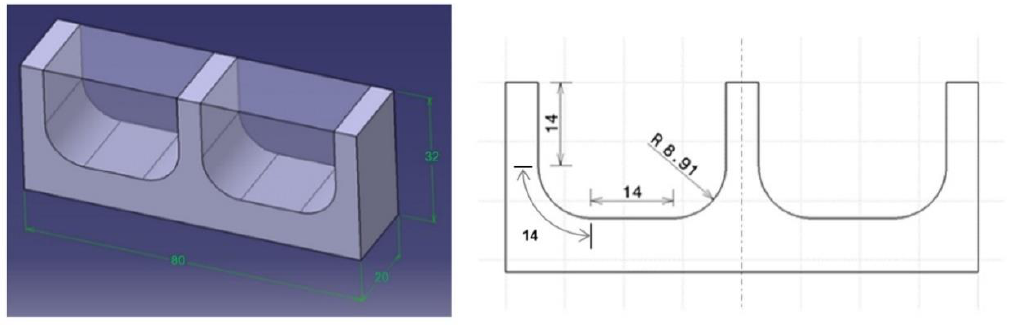
Figure 4. Final geometry of machined workpiece in AISI H13 material of dimensions 20 mm × 32 mm × 80 mm as it is shown.